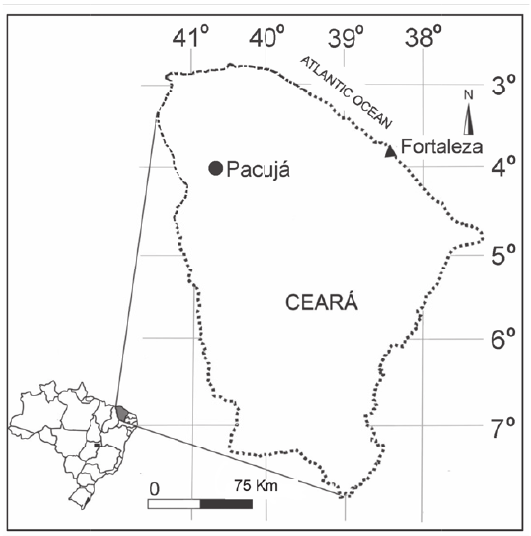
Figure 1 - Geographical location of the study area.